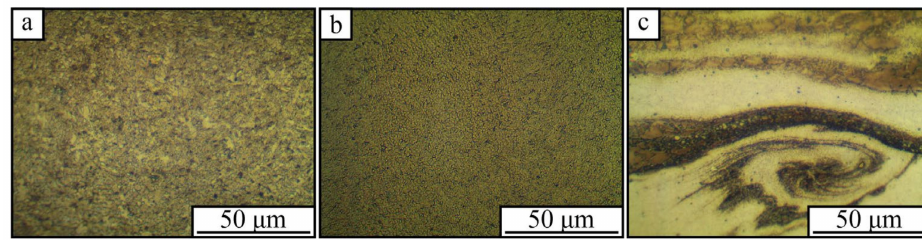
Figure 9. Microstructure of Ti-6Al-4V alloy in the base metal ( a ), SZ ( b ), and IMC in SZ ( c